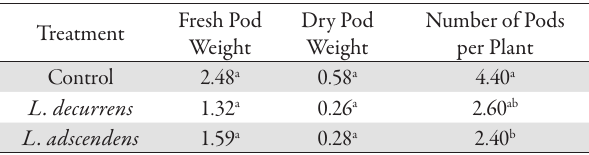
Tab. 6. Effect of Ludwigia decurrens and L. adscendens exudates on reproductive yield of Corchorus olitorious